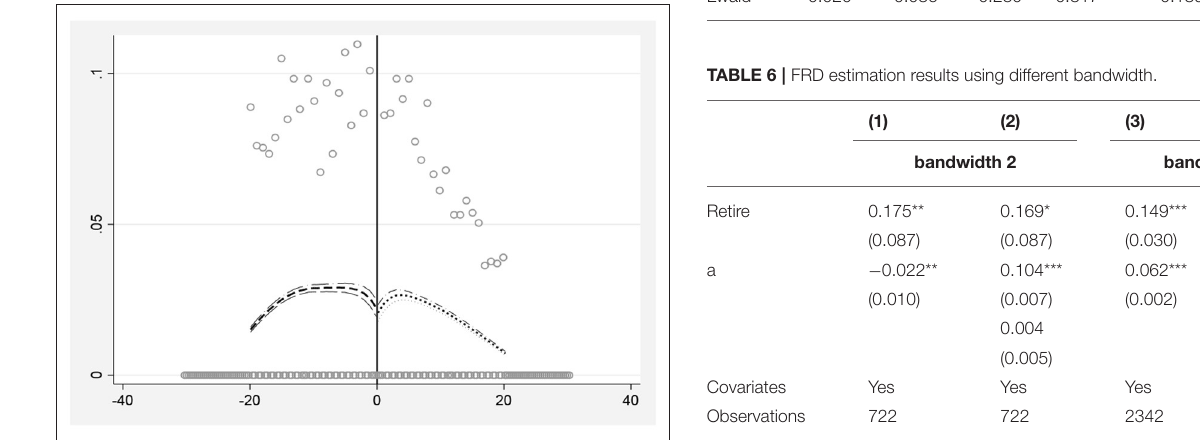
FIGURE 3 | The impact of retirement on happiness.